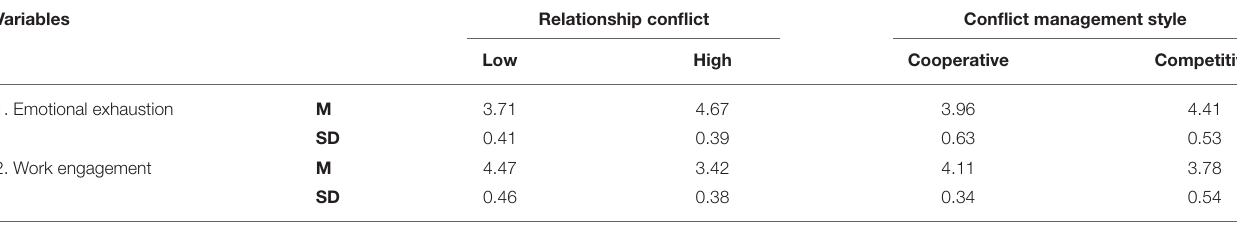
TABLE 2 | Descriptive statistics for relationship conflict and conflict management styles ( N = 60).